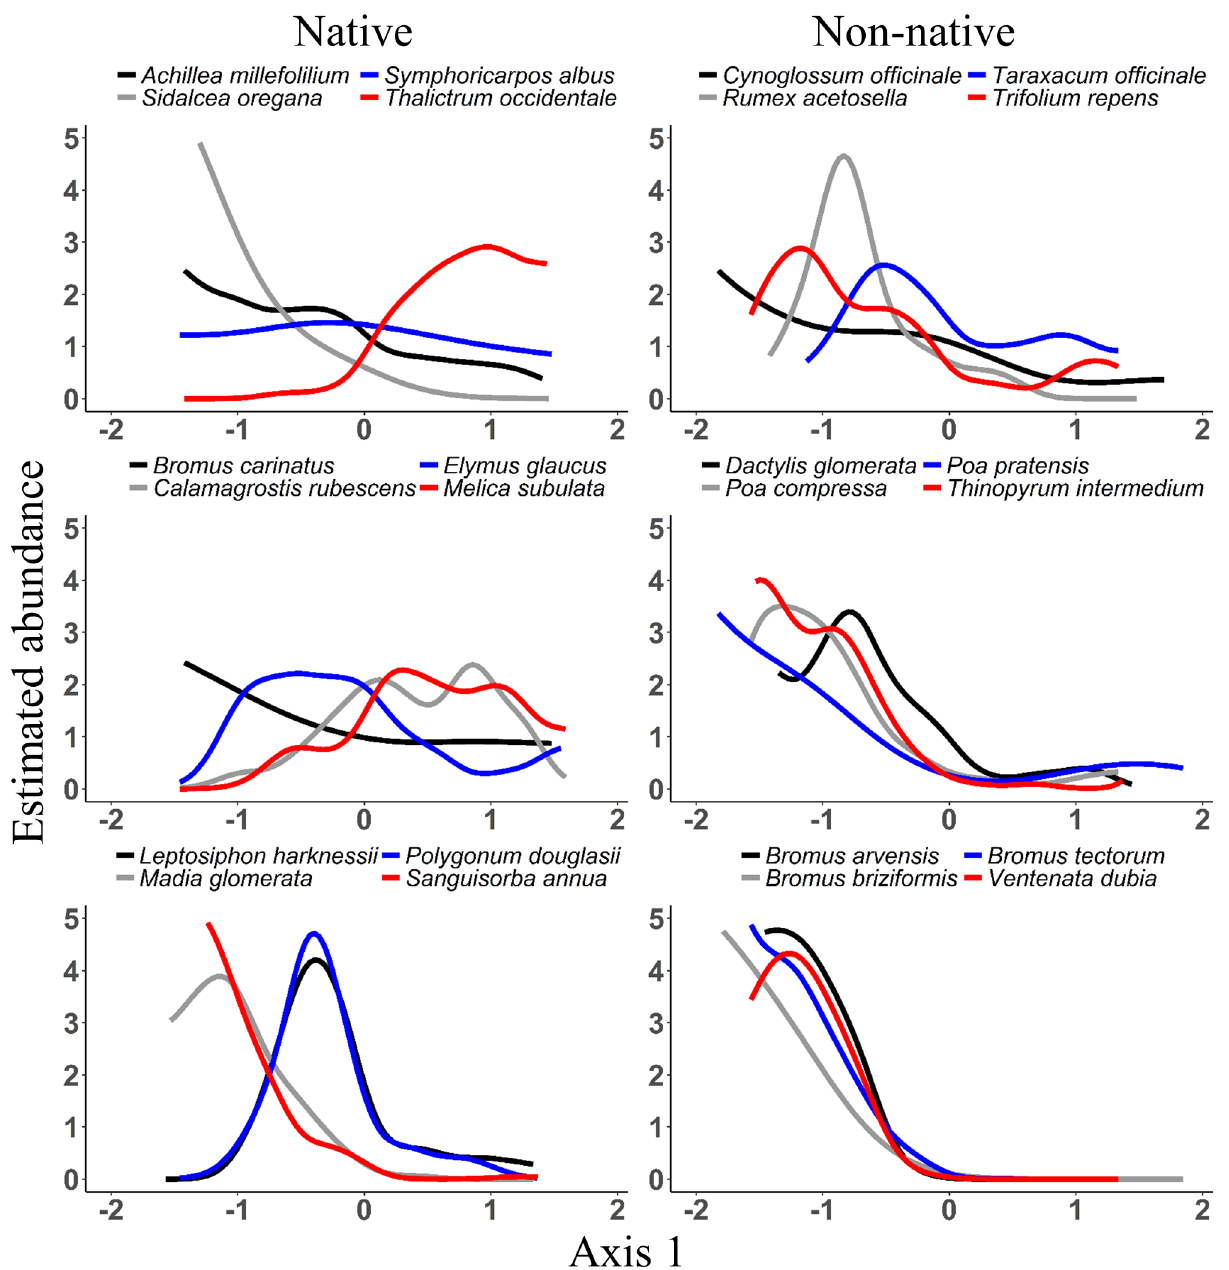
Fig 2. NPMR response curves for selected species along NMS Axis 1 (canopy gradient). Estimated abundances were relativized by the maximum value for each